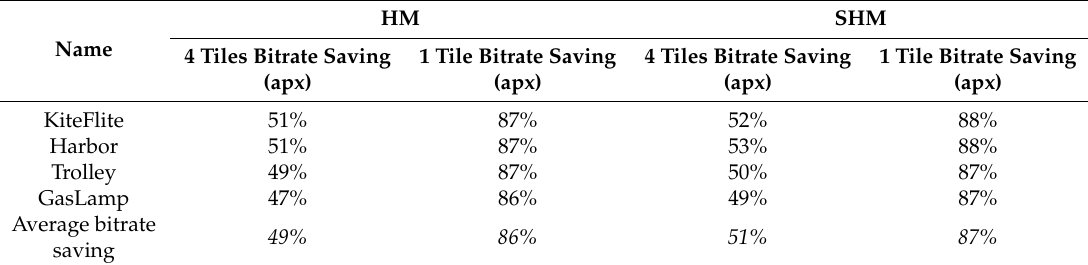
Table 7. Comparison ratio of bitrate to select and transmit tiles using modified SHM and HM